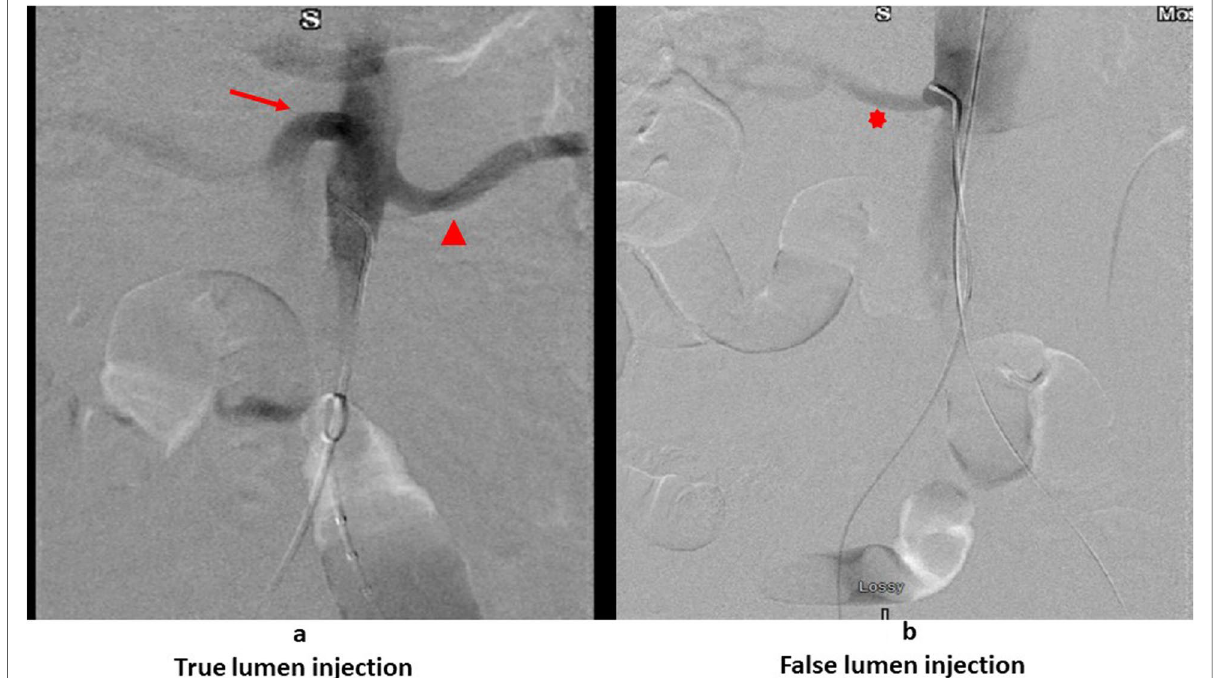
Fig. 4 a Contrast images of the descending aorta. True lumen injection, showing superior mesenteric artery (red arrow) and left renal artery (red arrowhead). Pigtail now pushed into chest to be followed by Transesophageal echocardiography. b Contrast images of the descending aorta. False lumen injection, showing right renal artery (red asterix). Requires catheter withdrawal and cannulation of true